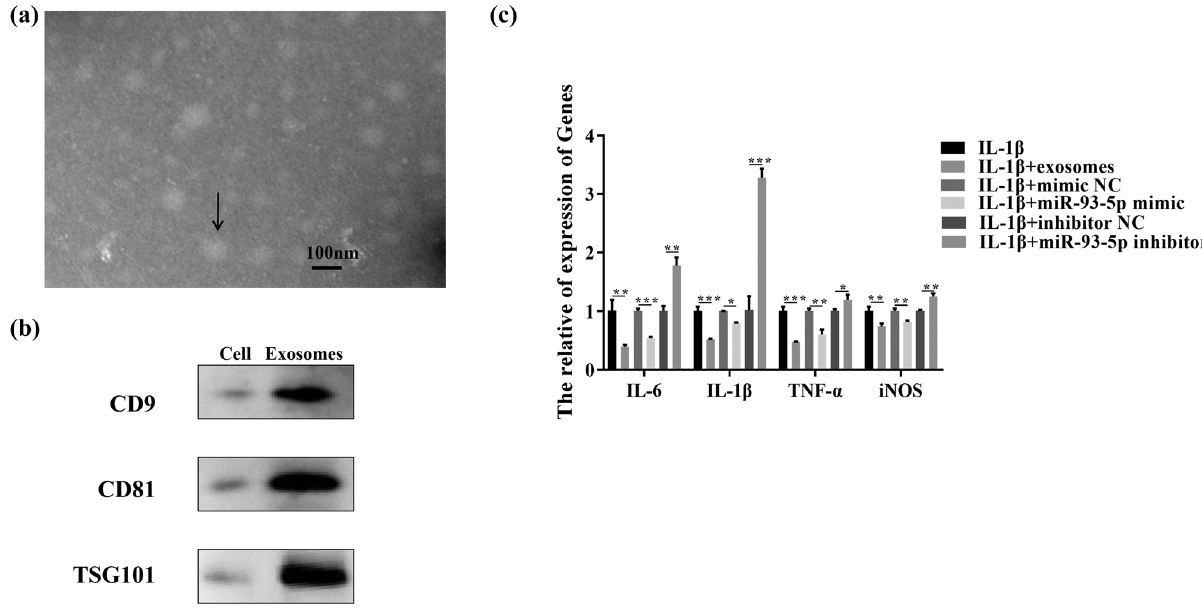
Figure 4: miR - 93 - 5p derived from ADSC - exos inhibited autophagy and apoptosis of IL - 1 β - treated chondrocytes. Note: ( a ) the structure of isolated exosomes was analyzed by TEM. ( b ) Exosome markers CD9, CD81, and TSG101 in ADSC - exos were characterized by the western blot assay. * P < 0.05; ** P < 0.01; *** P < 0.001. ( c ) RT - qPCR was performed to detect the expression of pro - in fl ammatory factors ( IL - 6, IL - 1 β , TNF - α ) and iNOS in IL - 1 β , IL - 1 β + exo, IL - 1 β + exo + inhibitor/mimic NC, and IL - 1 β + exo + miR - 93 - 5p inhibitor/mimic group. * P < 0.05; ** P < 0.01; *** P <